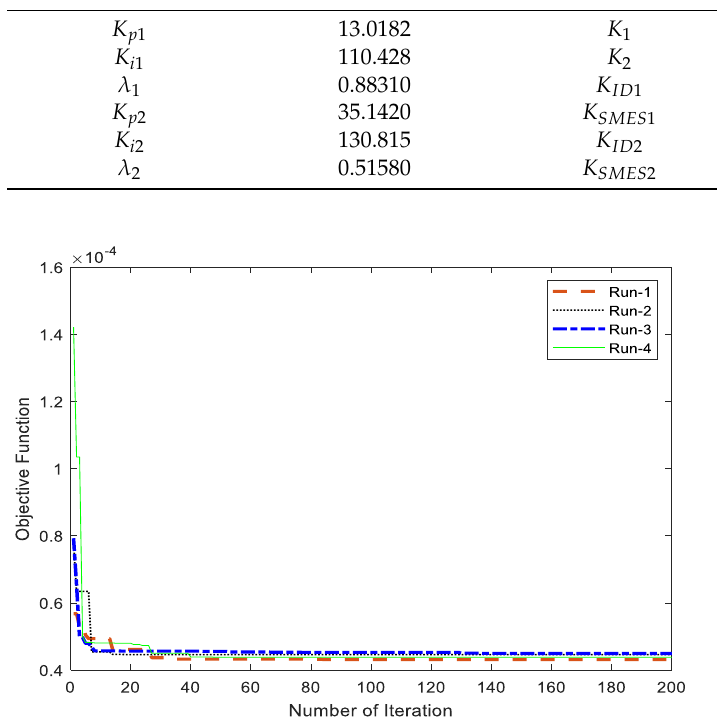
Figure 7. Convergence of WOA algorithm for FOC-based SMES design. Table 1. System Parameters.